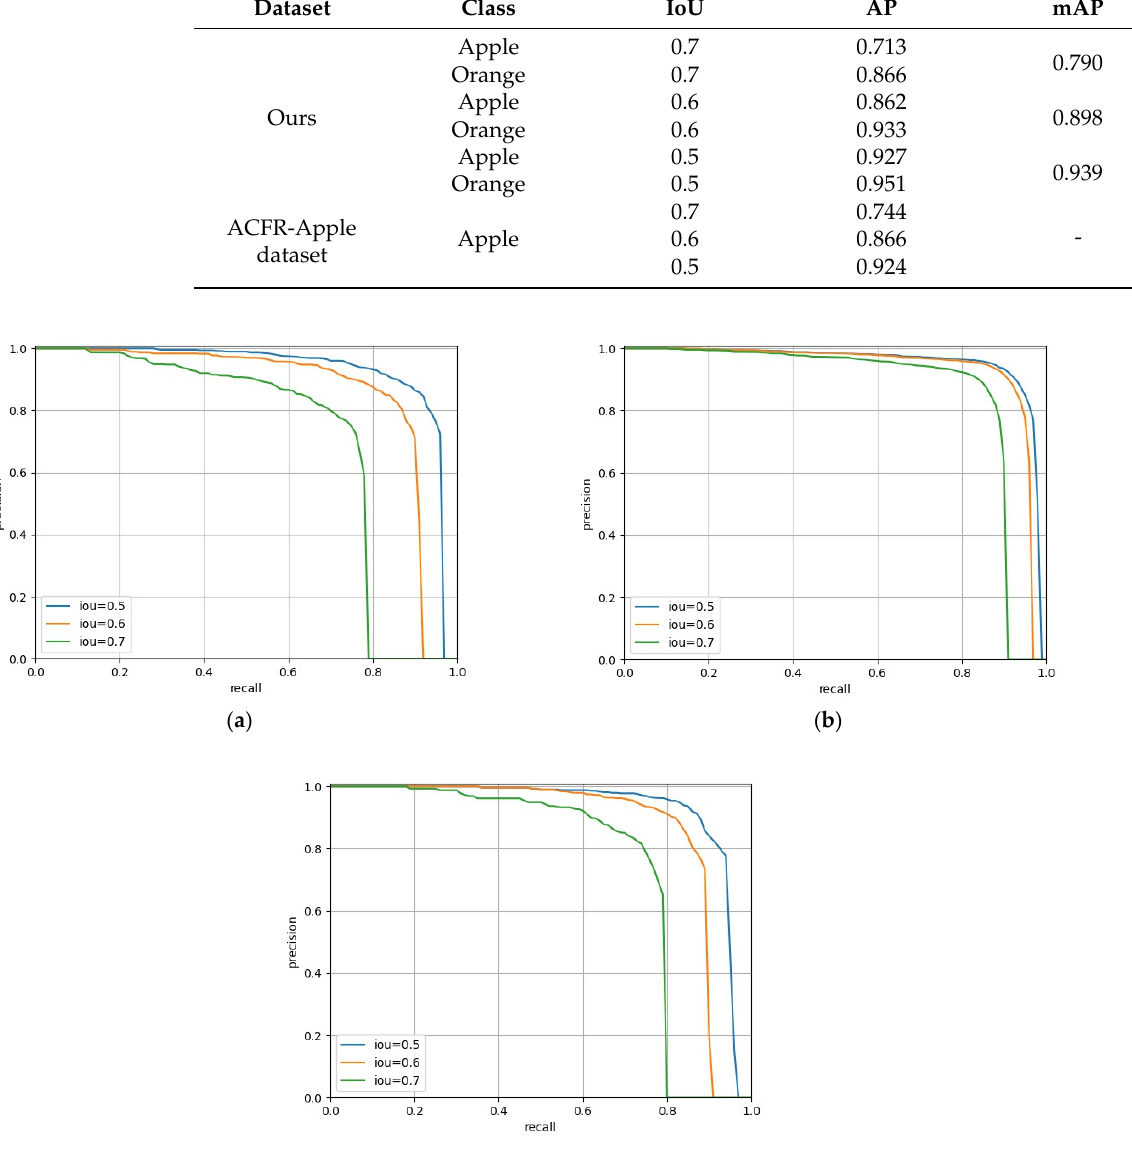
Table 3. The quantitative results of the model evaluation for fruit detection.